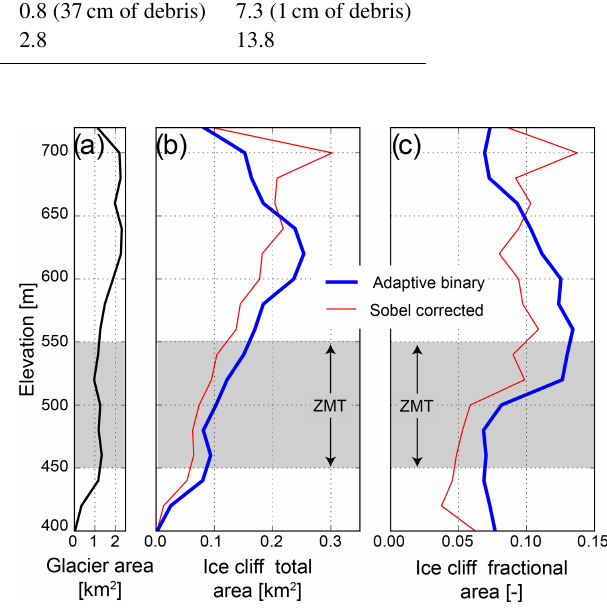
Figure 10. Results from the two ice cliff delineation methods with elevation. All panels use 20m elevation bins. (a) Glacier area as a function of elevation. (b) Ice cliff area as a function of elevation. The red line shows results from the SED approach after false posi- tives on dark-colored ice are removed. (c) Ice cliff area as a function of elevation, normalized by the glacier area within each elevation band. Note that fractional area × 100 is the percentage of ice cliff